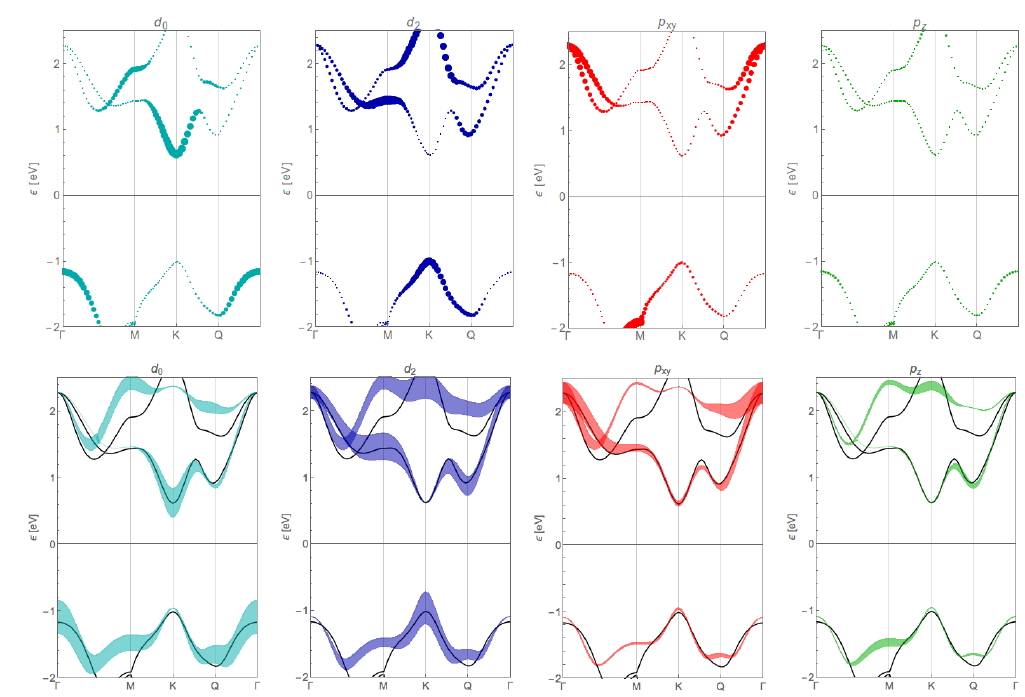
Figure B3. Same as Figure 4 but for WSe 2